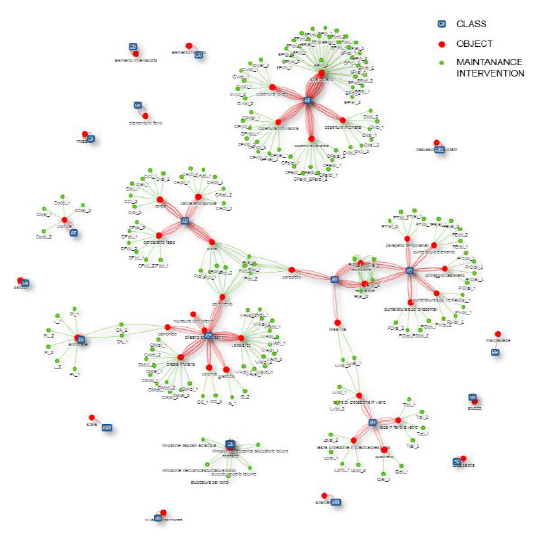
Figure 4: Example of relations between objects and maintenance interventions shared through different nodes (network created with vis.js - https://visjs.org/